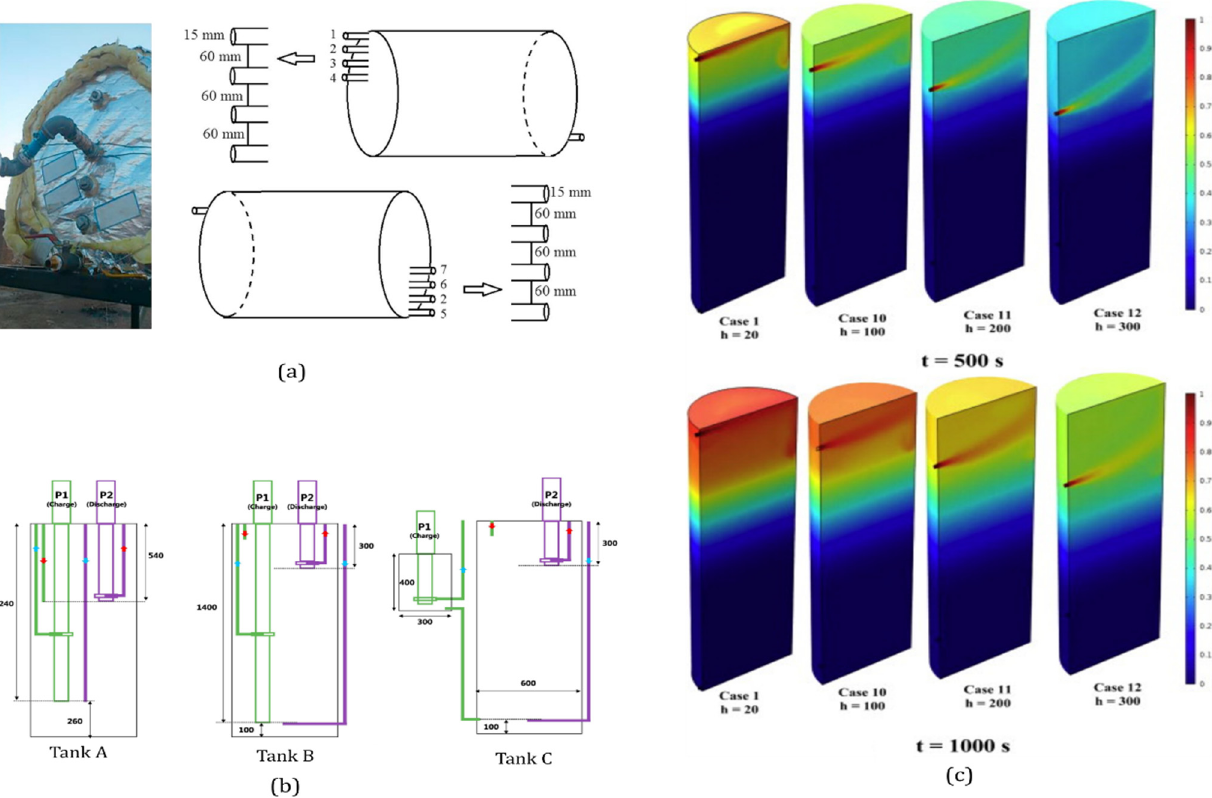
Figure 7. ( a ) Inlet-outlet location effect in the horizontal water storage tank [75]; ( b ) piping and configuration of solar salt thermal storage tank A, B, and C [78]; ( c ) effect of inlet location via temperature contours [47]. Reprinted with permission from refs. [47,75,78]. 4 October 2021 , Elsevier.